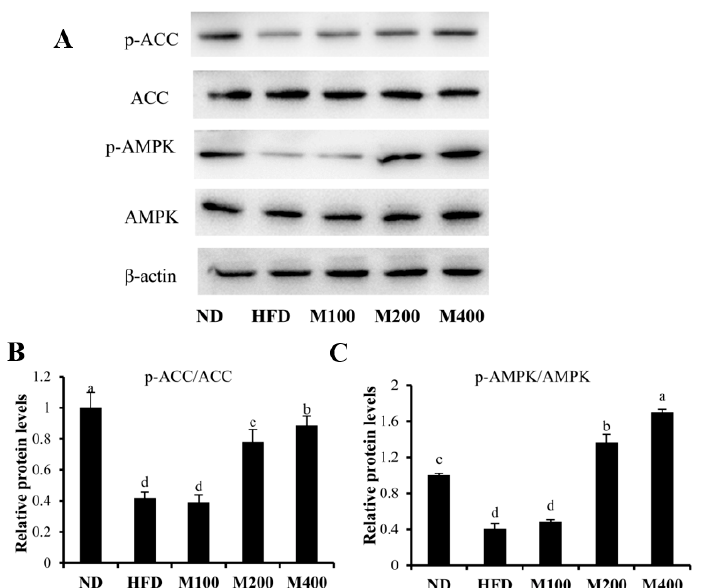
Figure 3. Effect of MFGM on the expression of adipogenesis-related genes and proteins in epididymal WAT. ( A ) Relative mRNA expression levels of adipogenic genes were measured using RT-PCR; ( B ) Adipogenesis related protein expressions were measured by western blot analysis. Protein expressions were quantified densitometrically using the software ImageJ 1.47v (Wayne Rasband, Bethesda, MD, USA), and were arbitrary units after correction for loading differences by measuring the amount of β -actin. Means ± SE ( n = 3). Mean values with different letters indicate statistical significance ( p < 0.05).